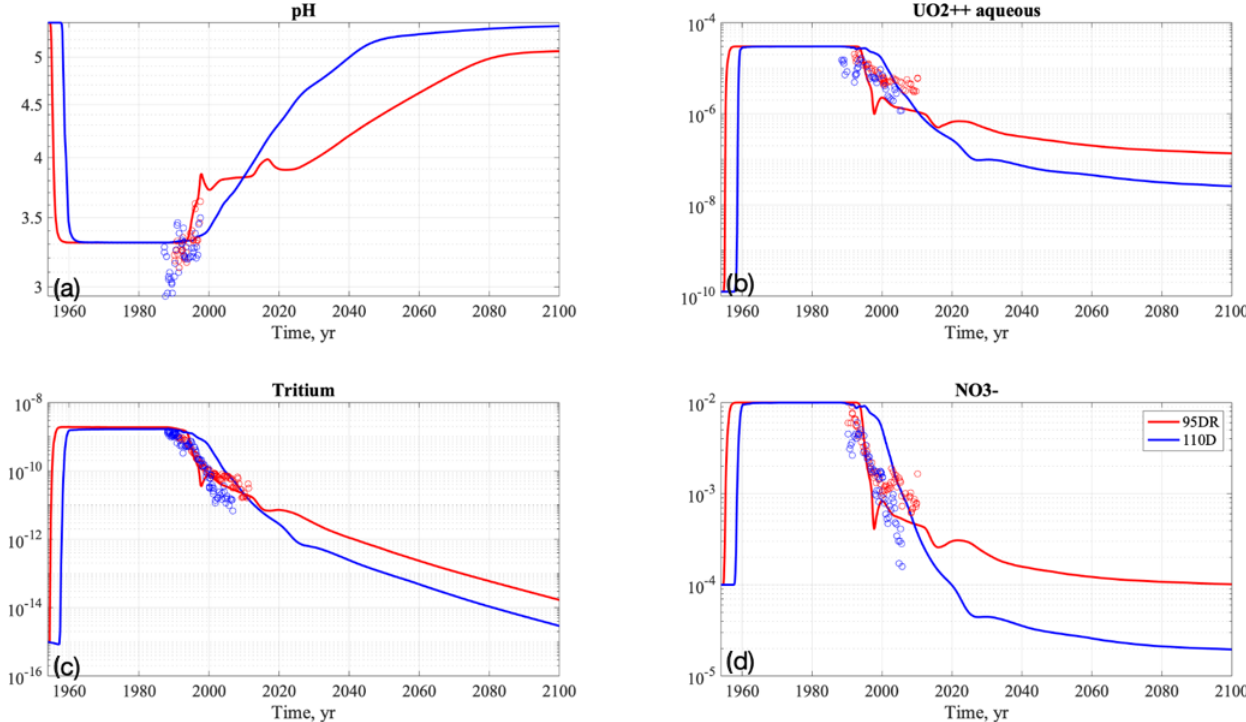
Figure 5. Breakthrough curves of pH, aqueous uranium, tritium, and nitrate at the source-zone well and downgradient well in the base case over the simulation period